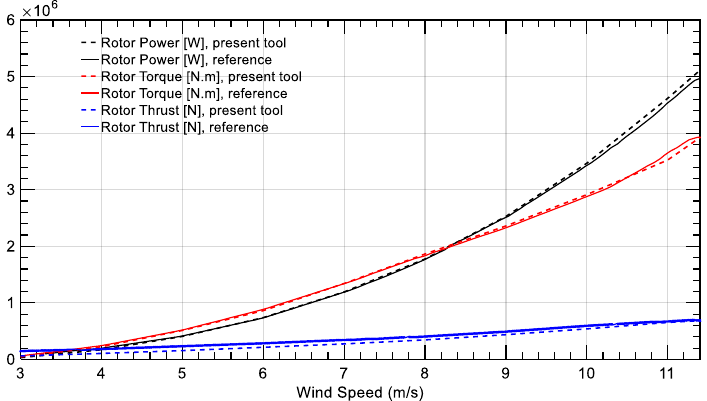
Figure 5. Steady state responses: comparison between results of the developed tool to NREL reference file.